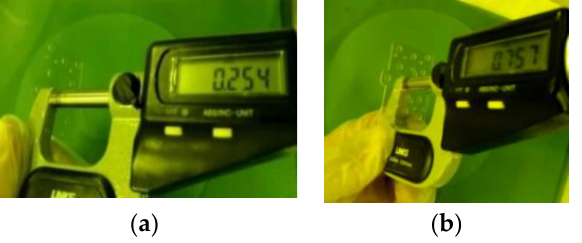
Figure 5. Spiral micrometer measuring SU8 chip’s thickness ( a ) the thickness of one layer and ( b ) the thickness of the SU-8 chip1 or 3.